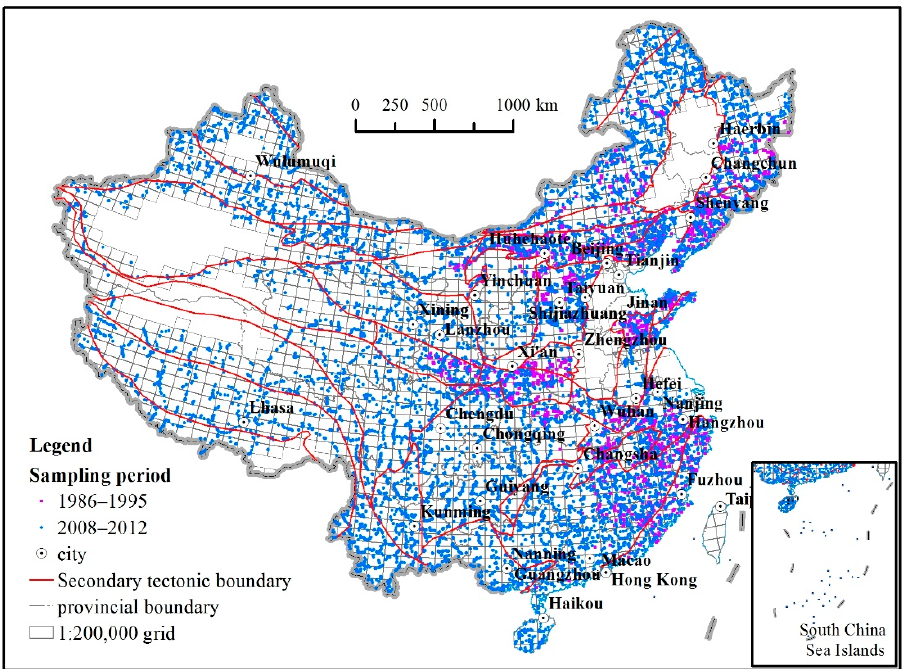
Figure 1. Distribution of sampling points (blue and violet) of rocks. The boundary of the secondary tectonic was drawn by Ren et al. [22].